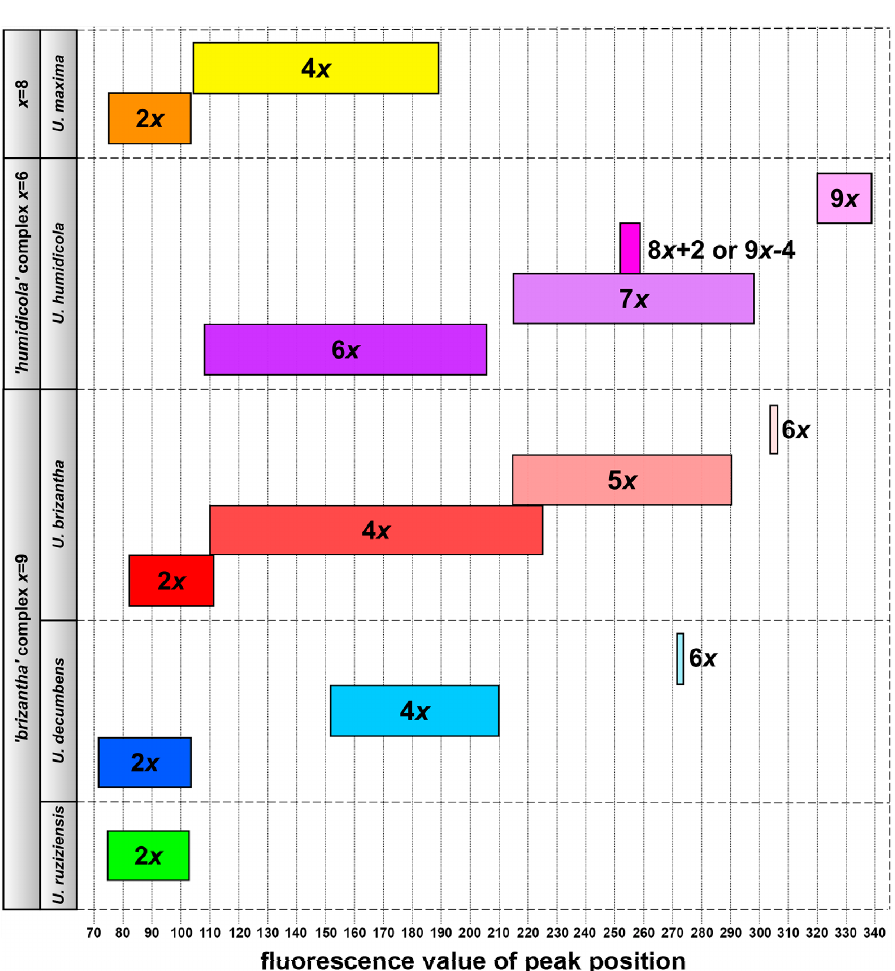
Figure 5. Ranges of fluorescence values of the peak positions for different ploidy levels of the most numerous species ( ‘brizantha’ agamic complex: U. ruziziensis, U. decumbens, U. brizantha ; ’ humidicola ’ agamic complex: U. humidicola ; U. maxima ) in CIAT germplasm